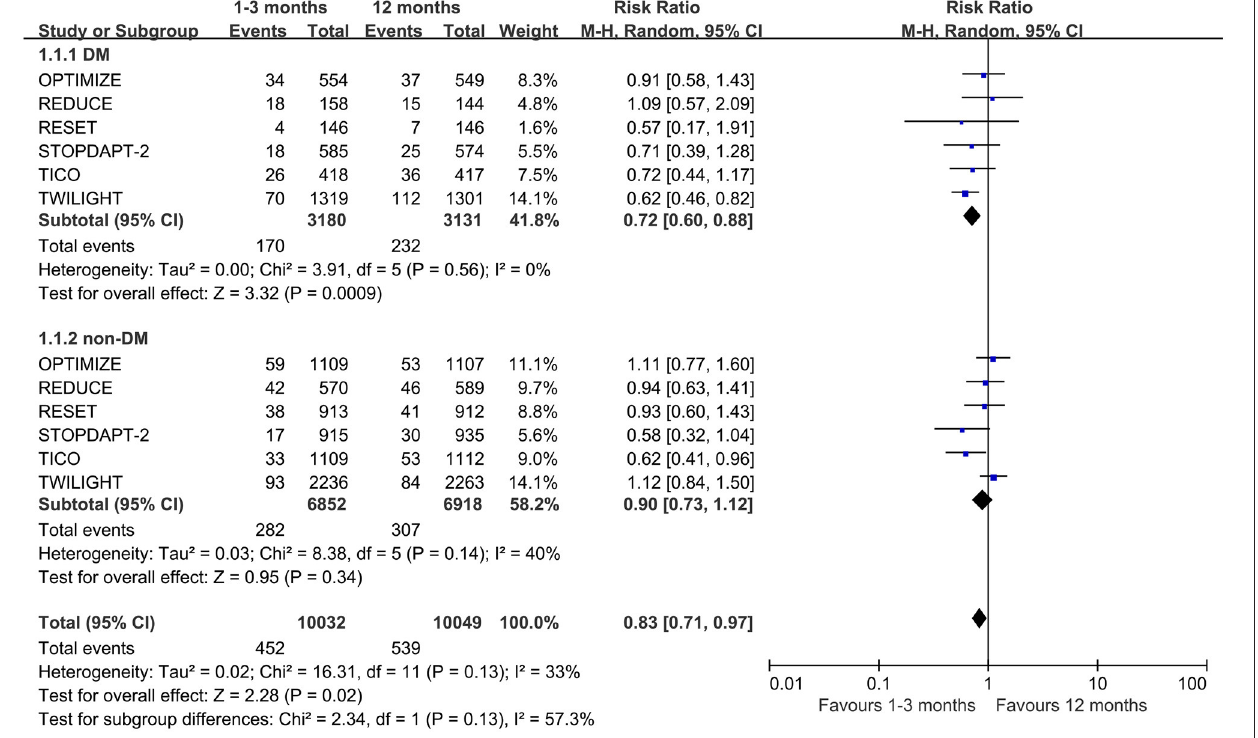
FIGURE 2 | Forest plot of primary outcome (NACE) in patients with or without diabetes mellitus according to duration of